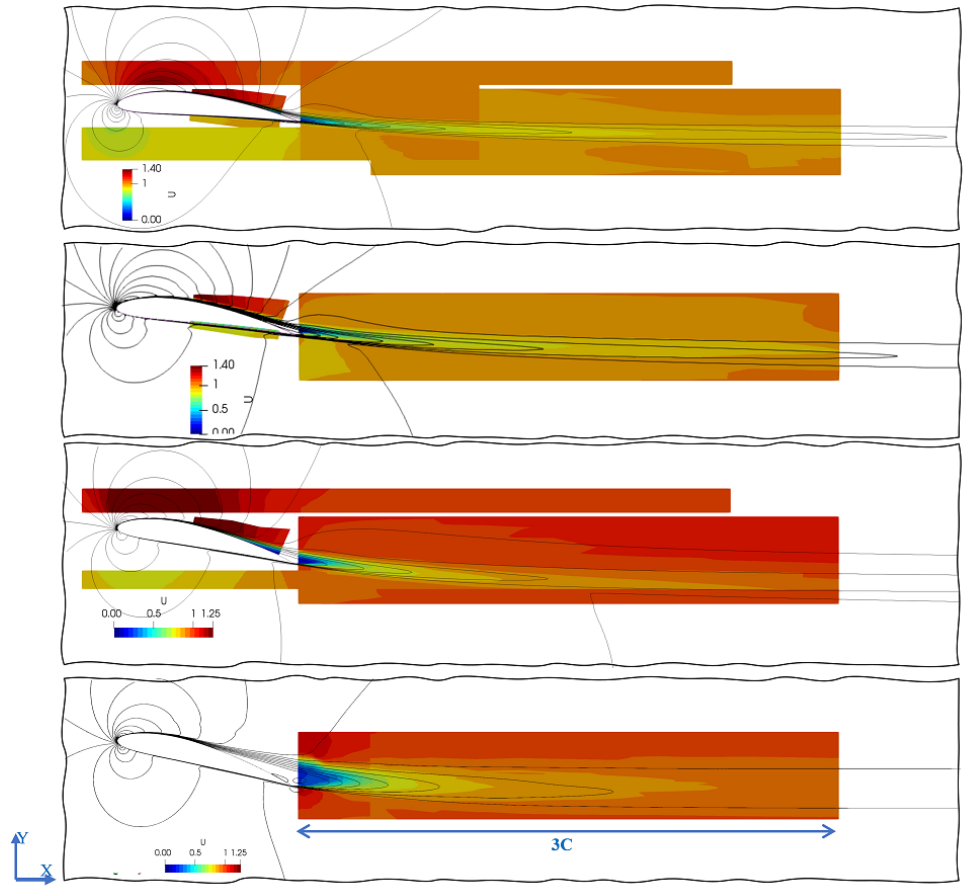
Figure 8. Velocity field for AOAs of 5 ◦ ,8 ◦ ,11 ◦ , and 14 ◦ : CFD contour lines along with EXP colour map. Part of the CFD domain is shown, and the EXP domain is according to Figure